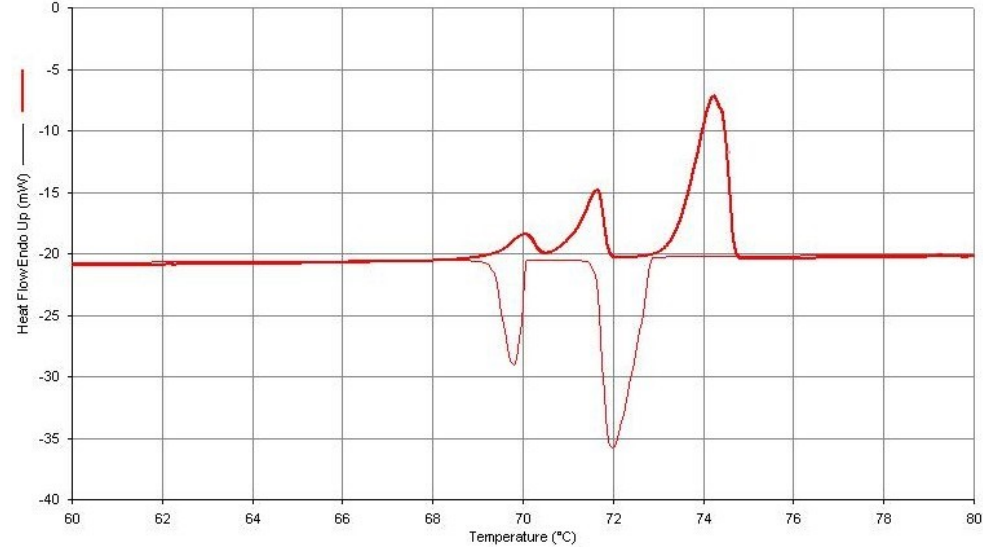
Figure 3. DSC Thermal Curve (Upper) for a 1.460 mg Sample of n ‐ Hexatriacontane Obtained at a Dynamic Heating Rate of 2 °C/min Followed by a Dynamic Cooling Rate of 2.0 °C/min (Lower).